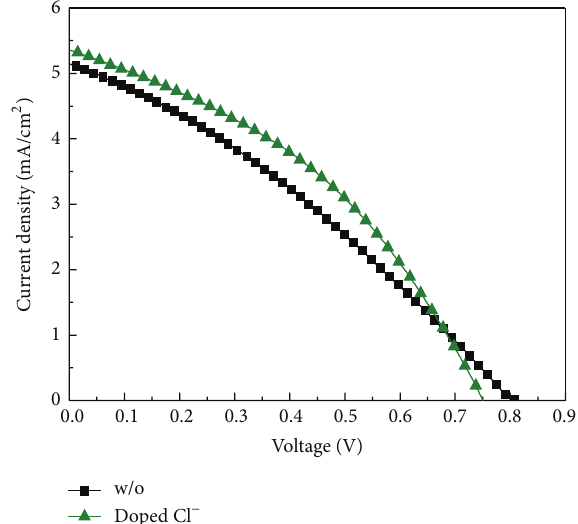
Figure 2: J - V characterization of the optimal PSCs with/without Cl incorporation.